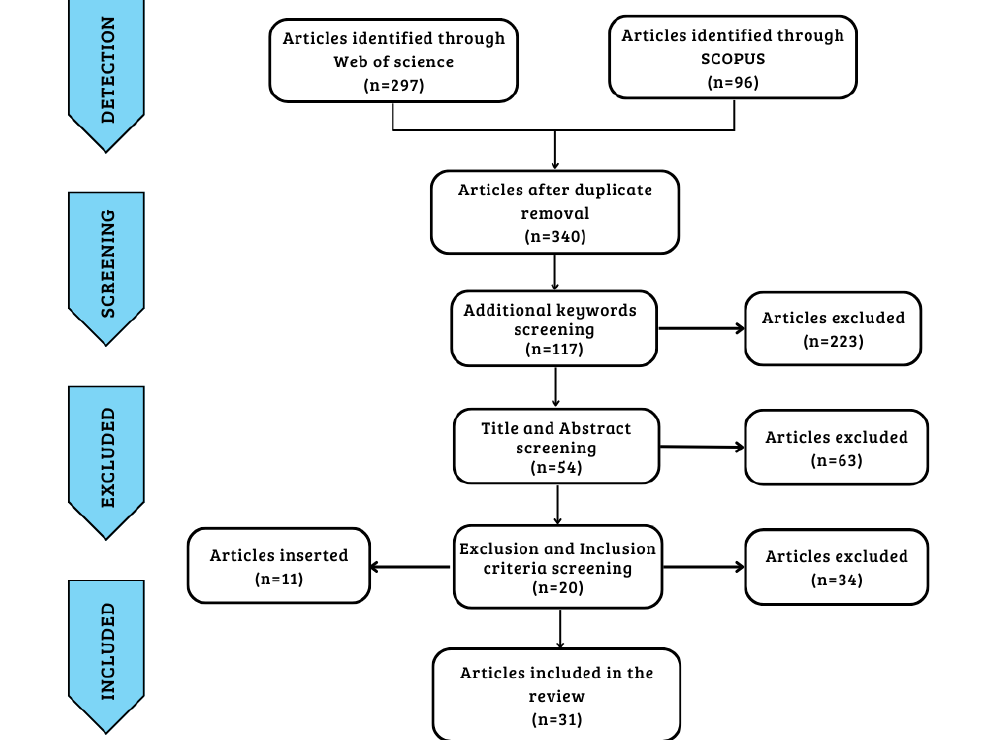
Figure 1. Prism diagram of research strategy